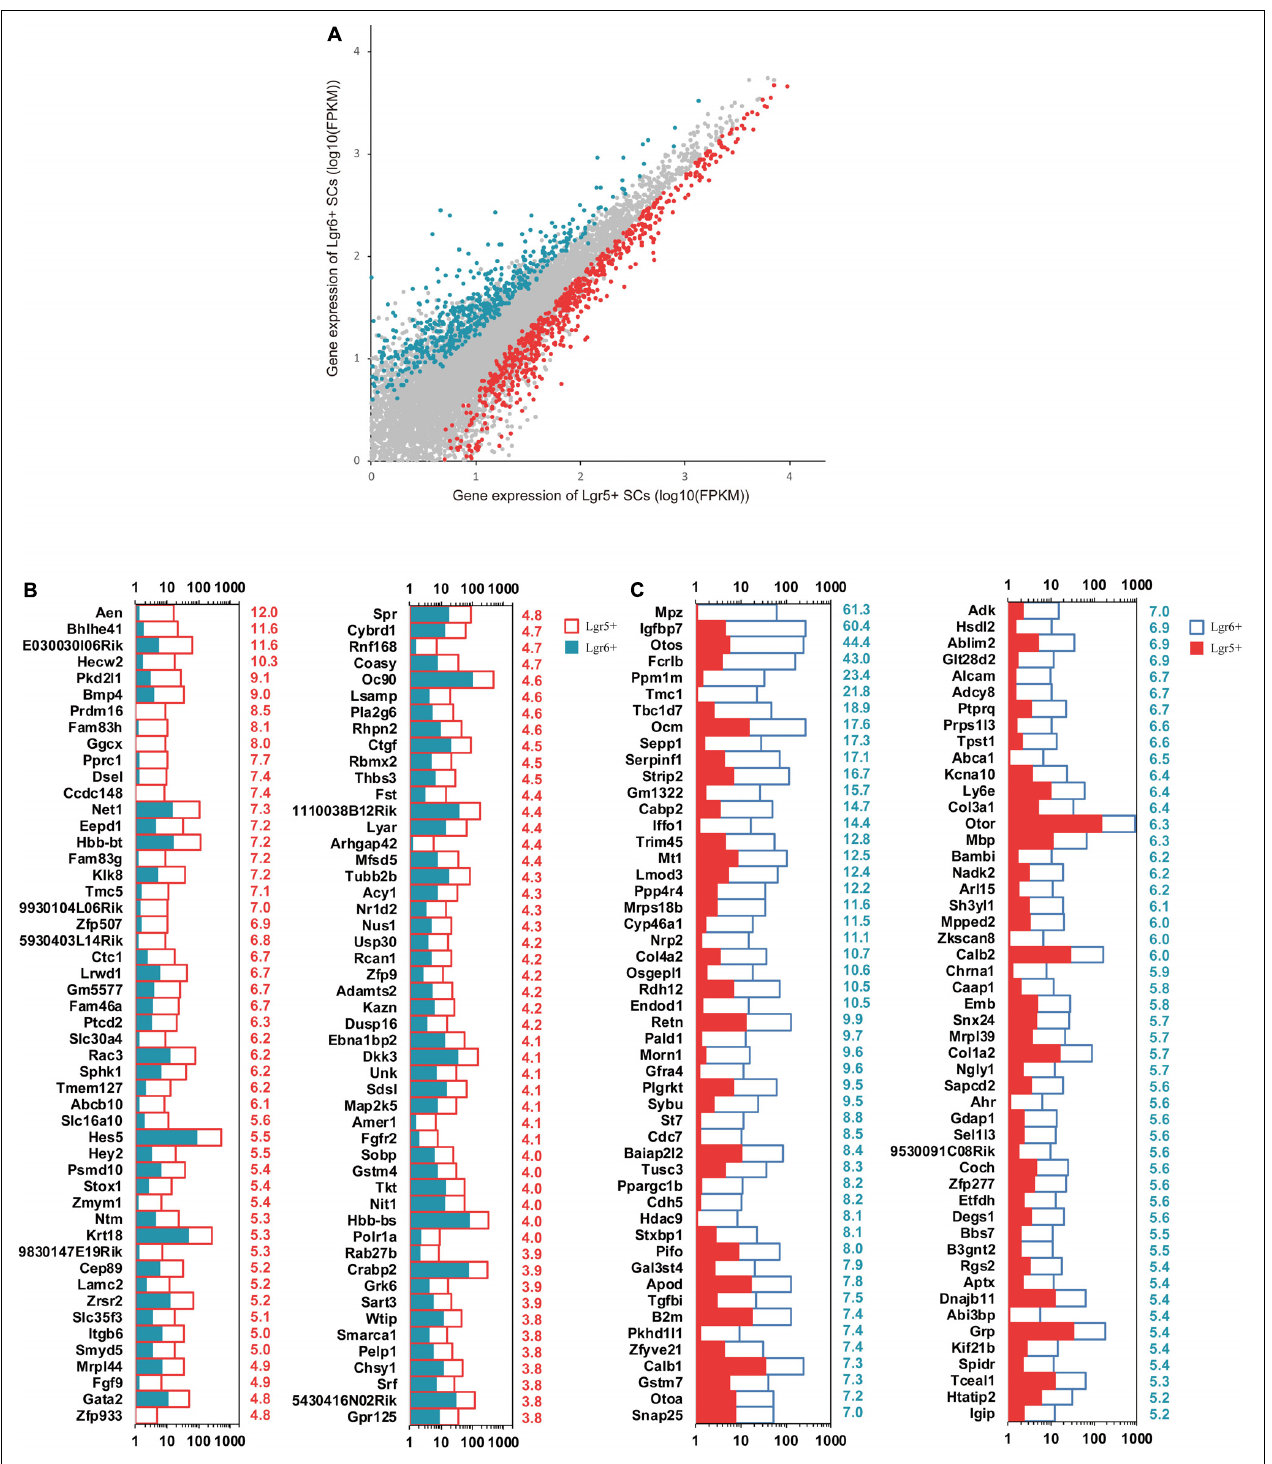
FIGURE 4 | Differentially expressed genes in Lgr5+ progenitors and Lgr6+ progenitors. (A) X-Y scatter plot showing differentially expressed genes in Lgr5+ progenitors and Lgr6+ progenitors. The red dots represent highly expressed genes in Lgr5+ progenitors, and the blue dots represent highly expressed genes in Lgr6+ progenitors. (B) The 100 most differentially expressed genes in Lgr5+ progenitors. The numerical values in red on the right side of each panel represent the fold difference in expression in Lgr5+ progenitors versus Lgr6+ progenitors. (C) The 100 most differentially expressed genes in Lgr6+ progenitors. The numerical values in blue on the right side of each panel represent the fold difference in expression in Lgr6+ progenitors versus Lgr5+ progenitors.